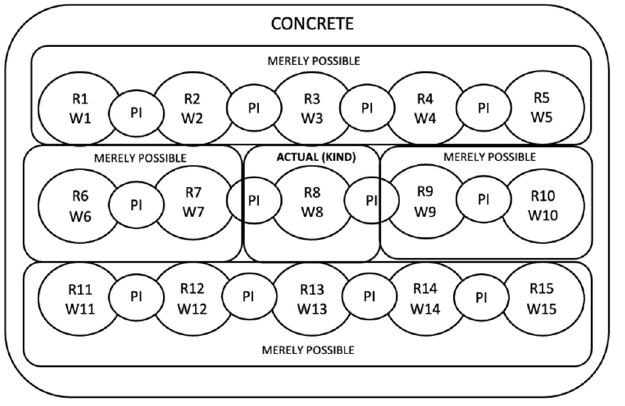
Figure 5. Leibnizian Realism with Overlap.